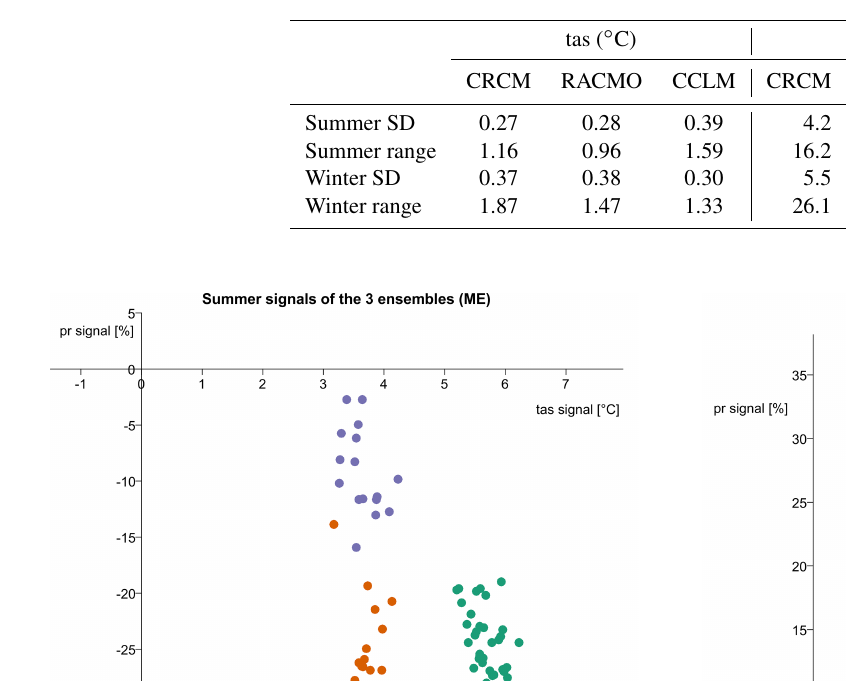
Table 3. Standard deviation and total range for changes in Figs. 2 and 3.